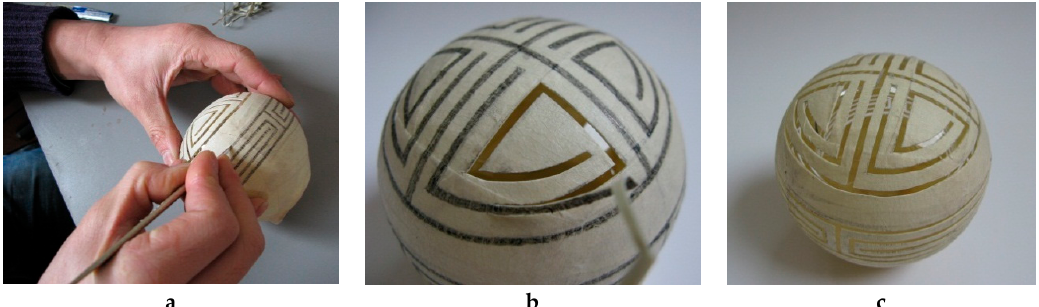
Figure 5. Cutting out a design with a scalpel blade.